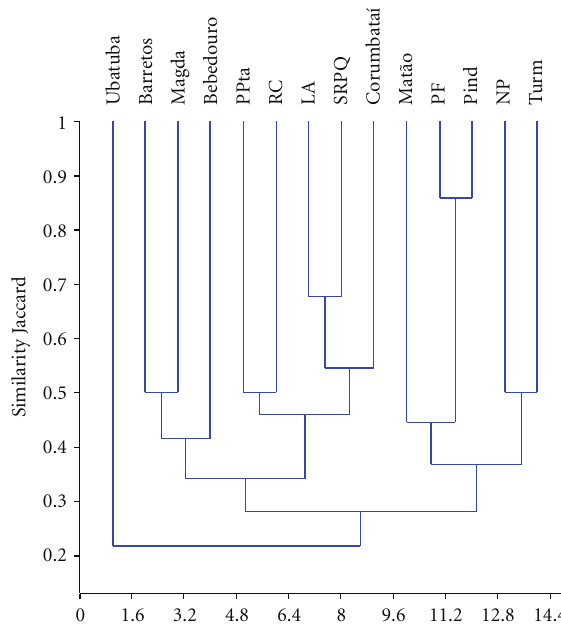
Figure 7: Similarity between the areas of S˜ao Paulo state where sur- veys of social waspswere done, using Jaccard index. PPta: Patroc´ınio Paulista, RC: Rio Claro, LA: Luiz Antˆonio, SRPQ: Santa Rita do Passa Quatro, PF: Paulo de Faria, Pind: Pindorama, NP: Neves Paulista, Turm: Turmalina.